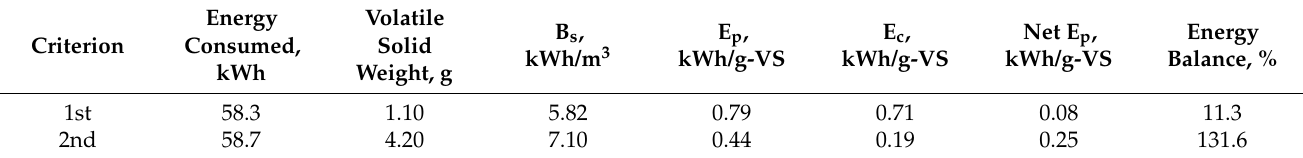
Table 16. Energy evaluation of optimisation criterion for date seed.